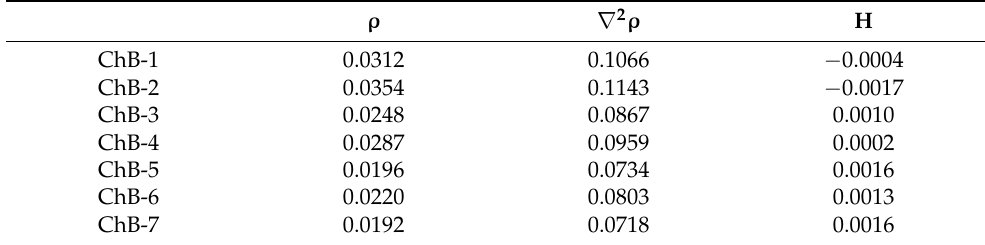
Table 2. Electron density ( ρ ), its Laplacian ( ∇ 2 ρ ), and energy density (H) at the Se ··· O BCP in the chalcogen-bonded dyads, all in au.